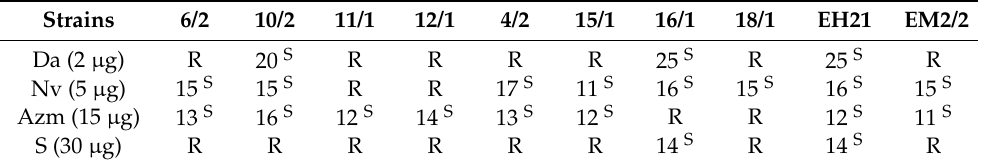
Table 2. Antibiotic profile of enterococci detected in raw goat milk.